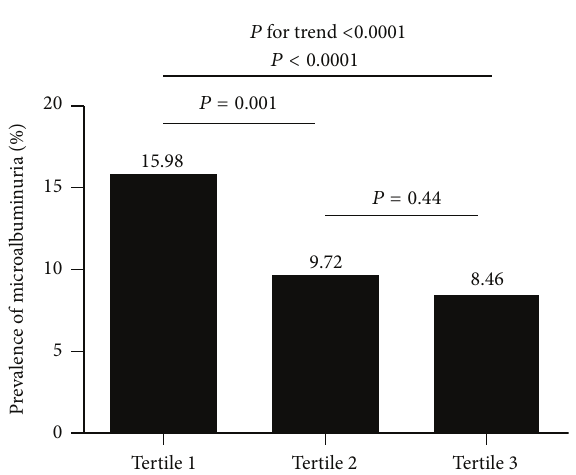
Figure 1: Prevalence of microalbuminuria by serum Mg tertiles (the serum Mg tertiles cutoff points were tertile 1: Mg < 0.86 mmol/L, and tertile 2: 0.86mmol/L ≤ Mg < 0.92 mmol/L, tertile 3: Mg ≥ 0.92